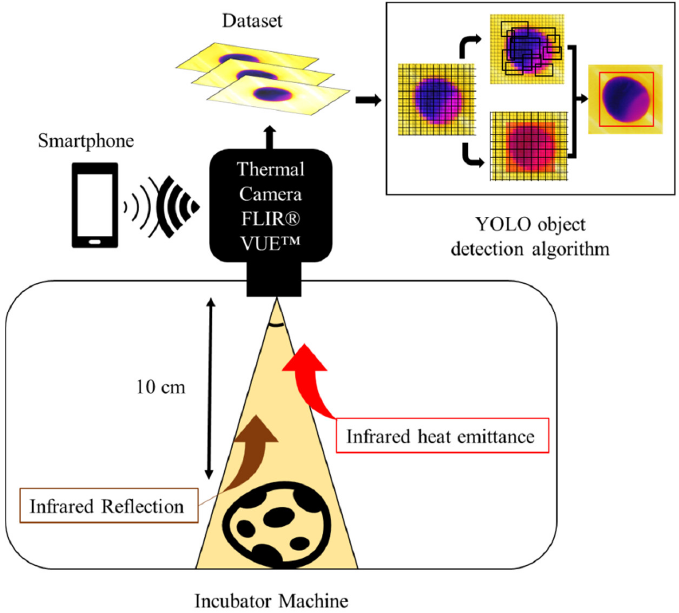
Figure 2. A schematic representation of the methodology proposed to collect thermal images from quail eggs. quail